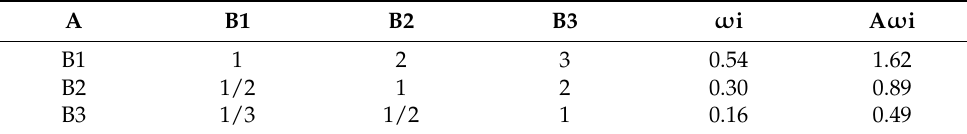
Table 6. A-B comparison